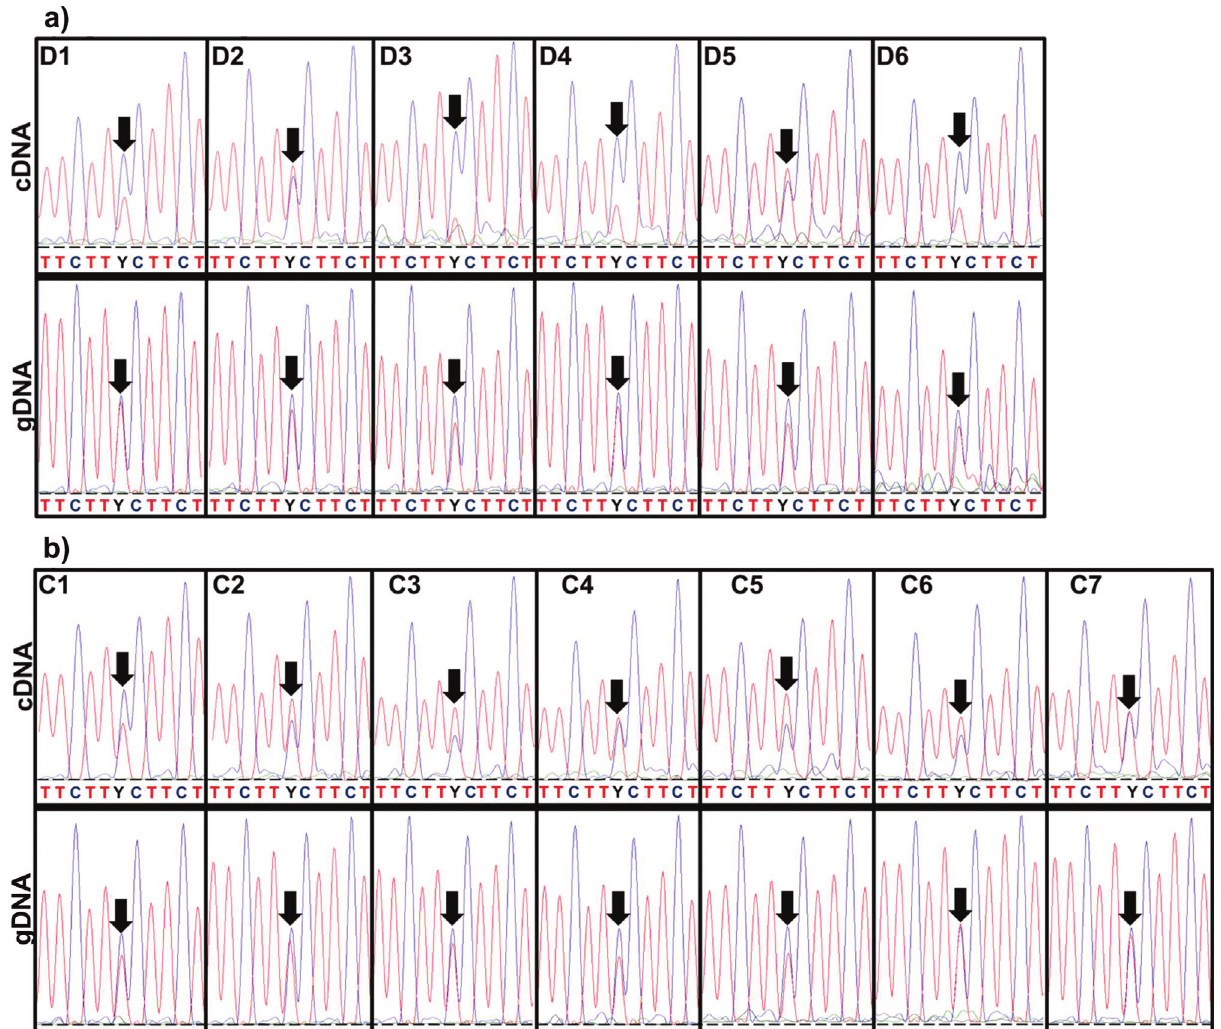
Figure 4 - Sequencing results of dyslexia family and controls. The rs600753 cDNA-sequences and the respective gDNA-sequences for six dyslexia fam- ily members (a) and seven controls (b). Arrows indicate position of